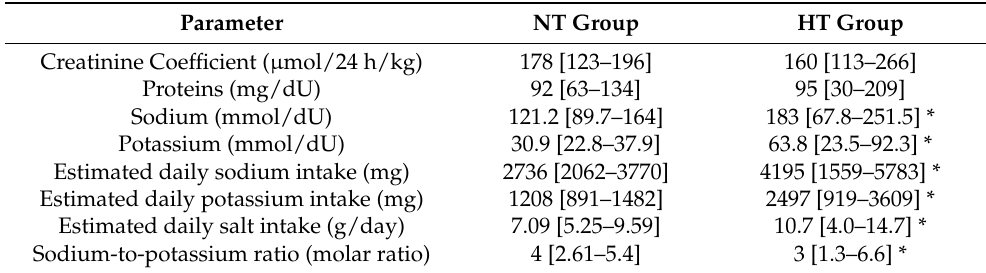
Table 2. 24-h Urine Biochemical